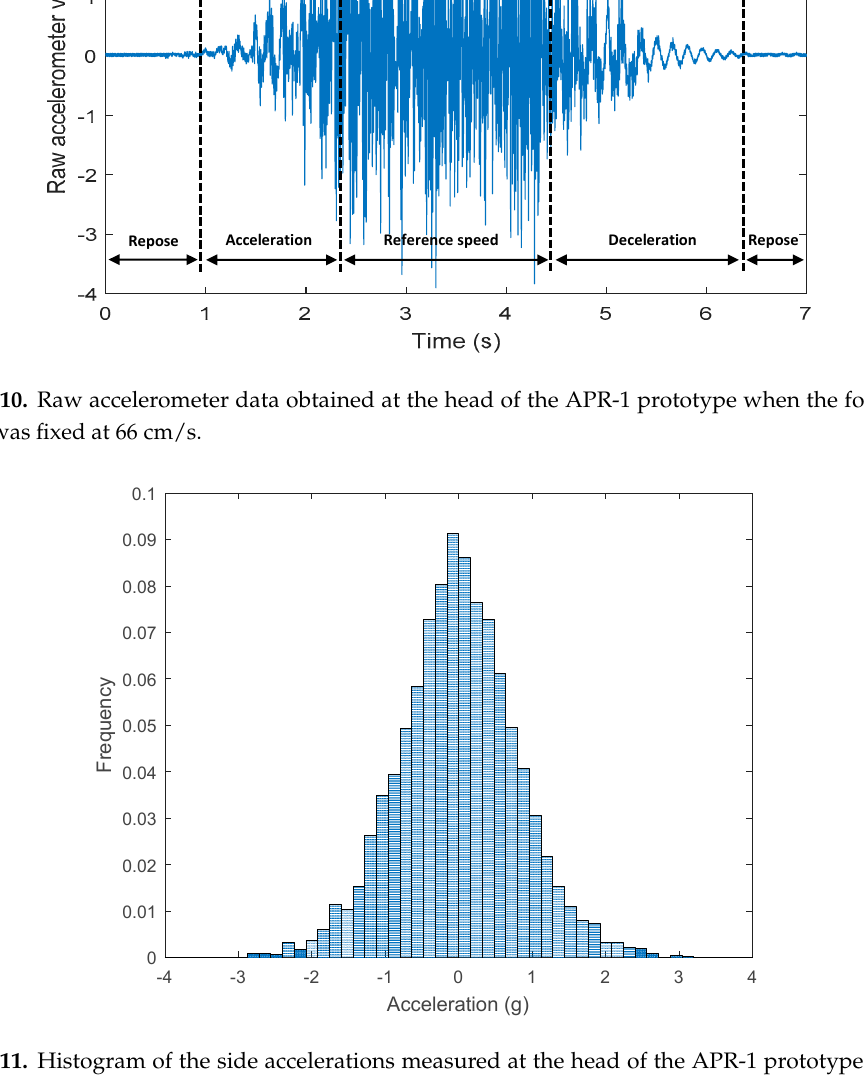
Figure 11. Histogram of the side accelerations measured at the head of the APR-1 prototype when moving at a constant velocity of 55 cm/s during a forward displacement.